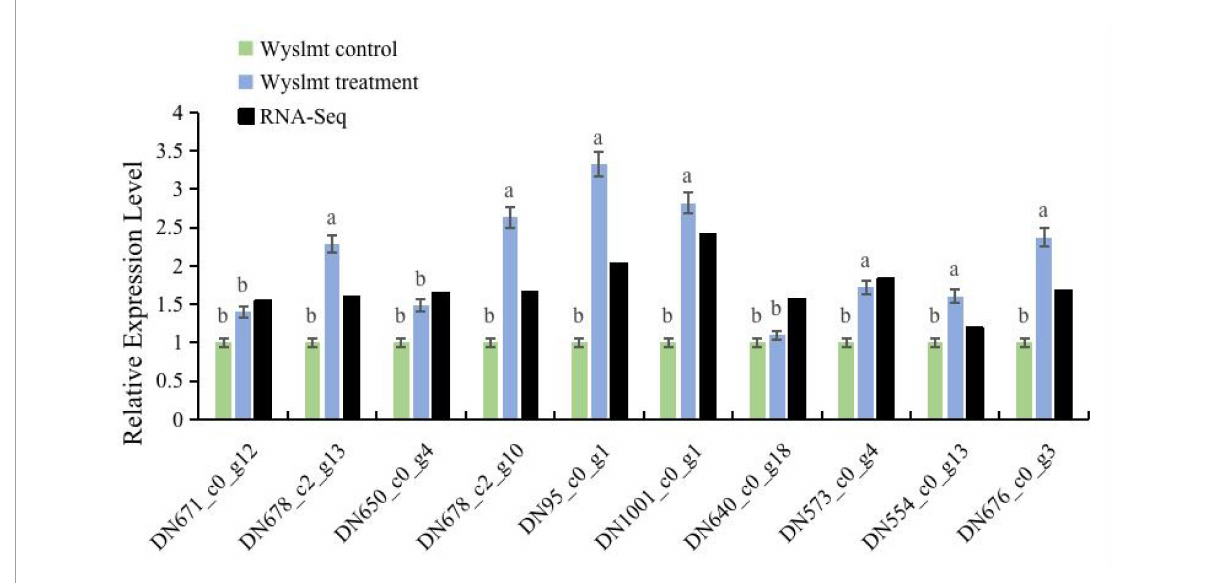
FIGURE6 The relative mRNA expression levels of DEGs in both the treatment and control groups. Black bars represent log 2 | FoldChange| (treatment group/control group) values from RNA-seq analyses. Error bars represent the standard deviation for three replicate samples. Different letters indicate significant differences between treatments ( P < 0.05).